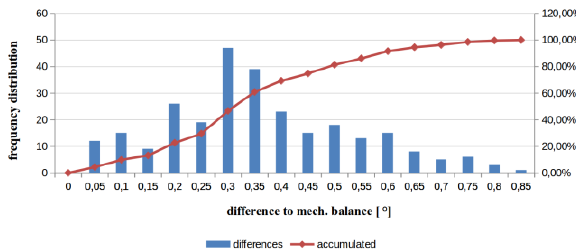
Figure 9. Differences of determined steering angles related to the mechanical balance using point-to-point matching